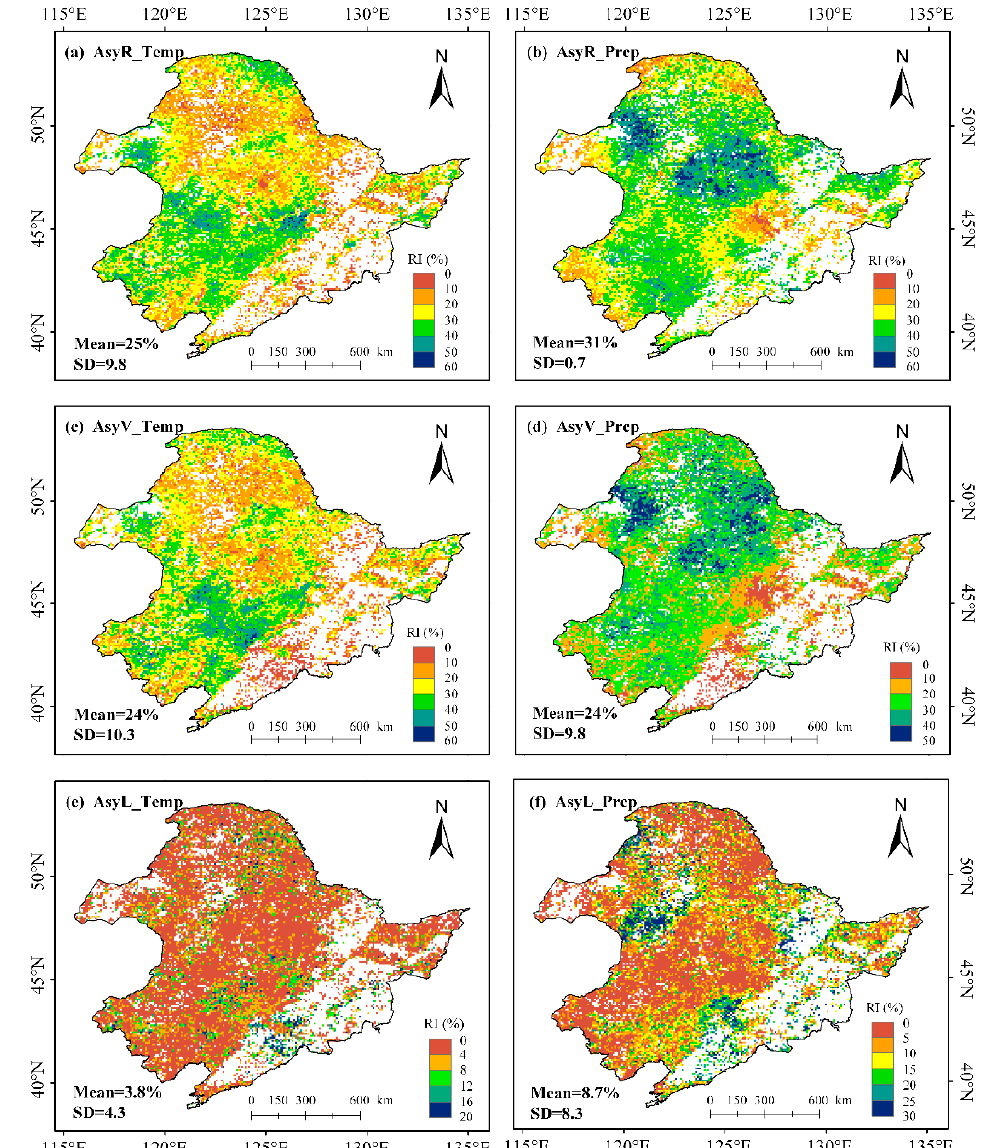
Figure 11. Spatial patterns of relative contribution of asymmetries in temperature (the first column) and precipitation (the second column) to vegetation growth asymmetries (in rows) at pixel scale (white grids are insignificant). RI denotes relative importance.